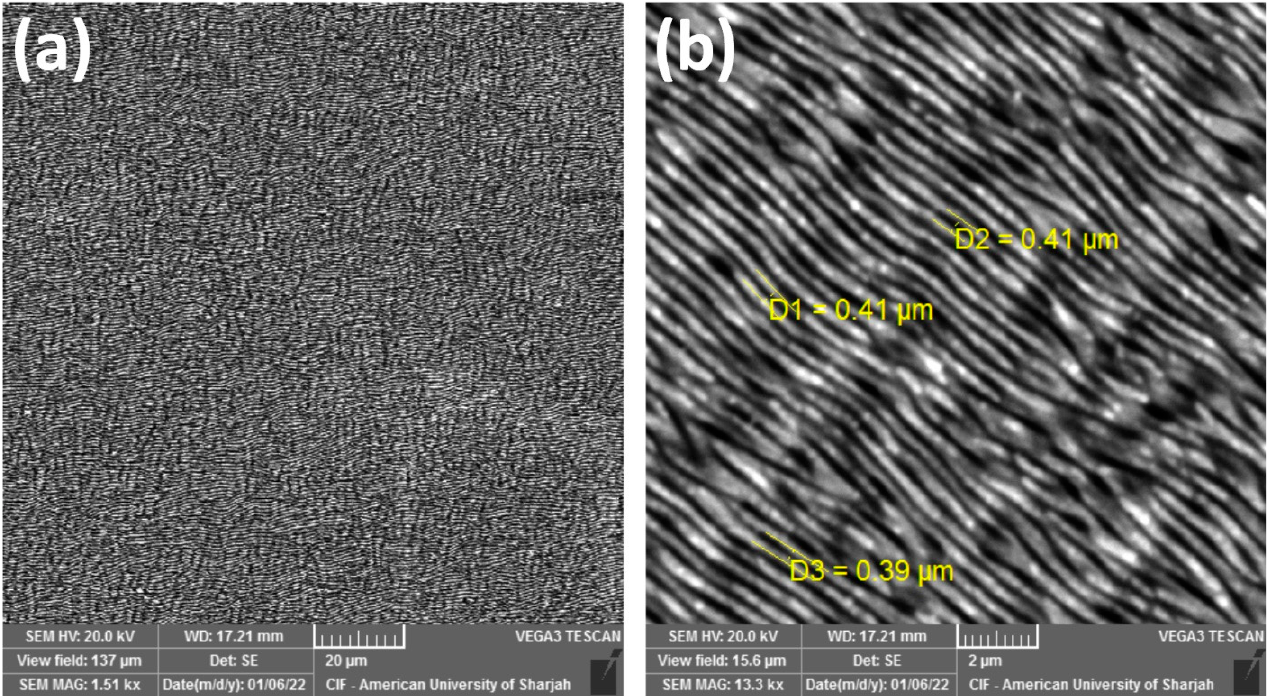
Figure 4. SEM micrographs at ( a ) 1.5 kx and ( b ) 13.3 kx magnifications of MoO x /MS obtained after laser-scanning Mo-1.5/MS with 40 fs pulses of 0.2 J/cm 2 fluence and 50 kHz repetition rate .